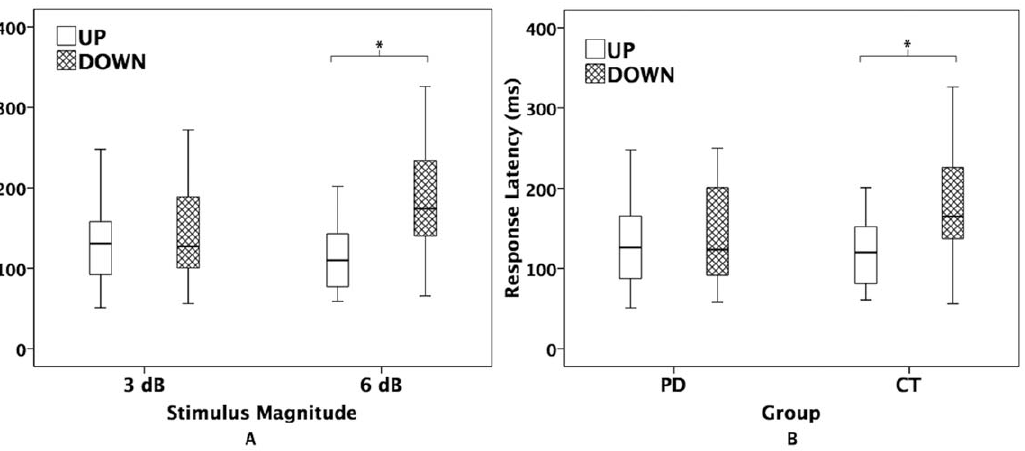
Figure 5. Box plots illustrating the effect of stimulus direction on the voice loudness response latencies as a function of stimulus magnitude (A) and testing group (B). Cross-hatched boxes and blank boxes represent the responses to downward and upward loudness-shift stimuli, respectively. The asterisks indicate significant differences between conditions.